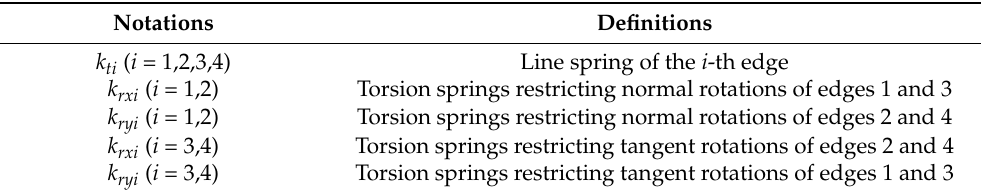
Table 1. Notations and definitions of boundary